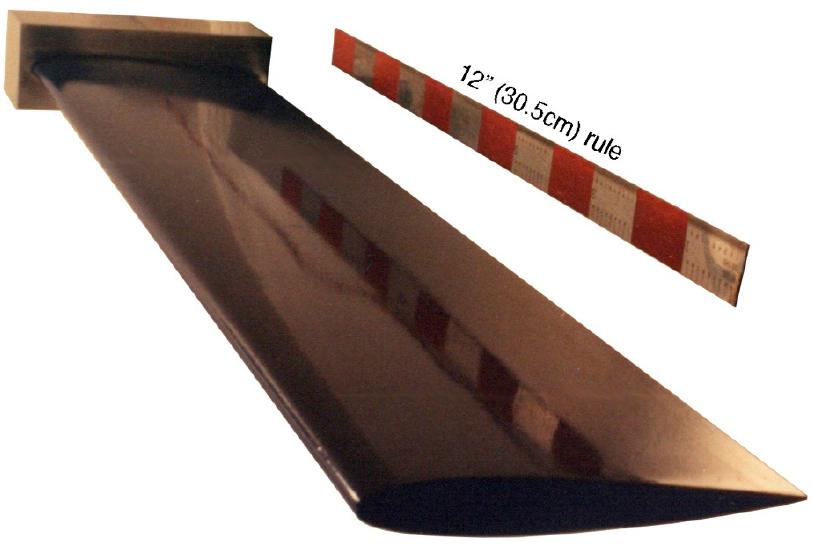
Figure 7. Finished DAP wing test specimen.